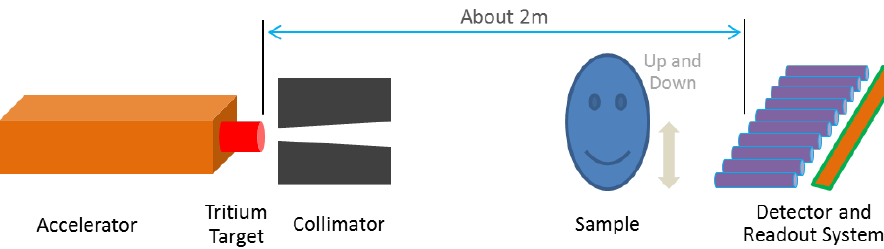
Figure 1. Sketch map of the scanning method by fast neutrons.